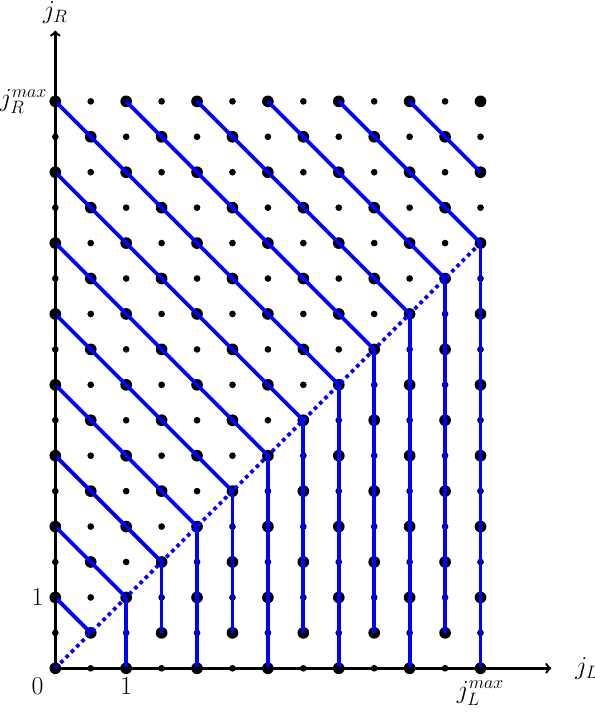
Figure 8 . Strict total order for ( j L ; j R ) at d =